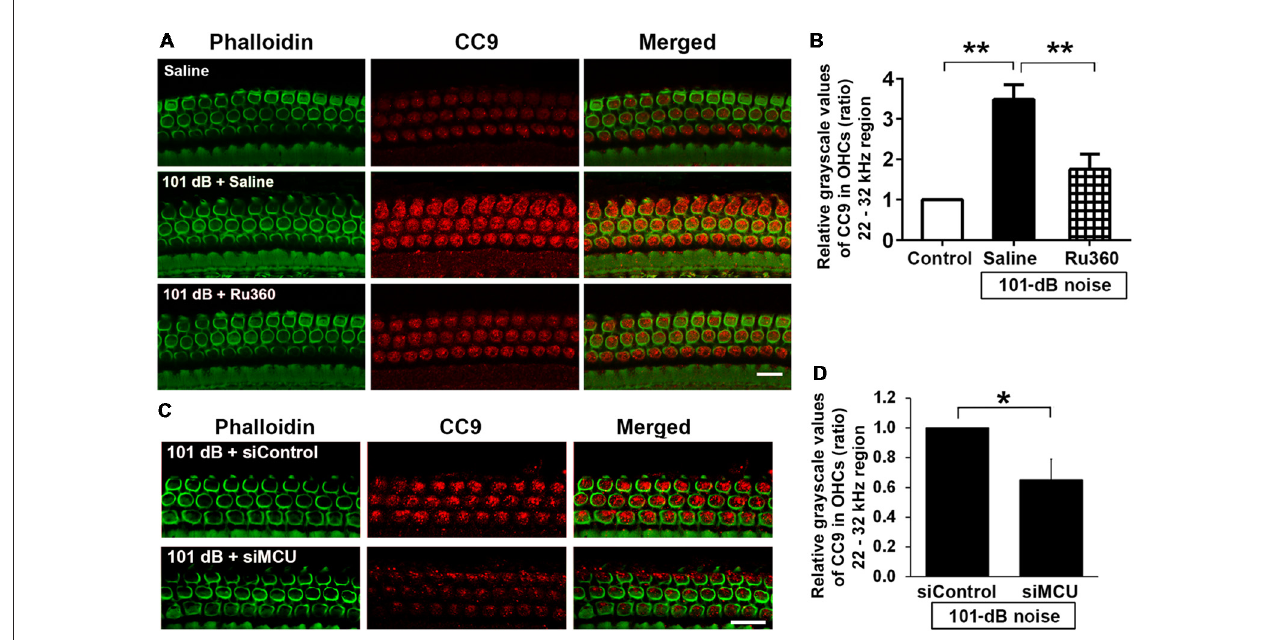
FIGURE 5 | Inhibition of MCU via the pharmacological inhibitor Ru360 or siMCU attenuated noise-induced increases in cleaved caspase 9 (CC9) in OHCs of the basal turn. (A) Representative images show an increase in immunoreactivity for CC9 (red) in OHCs stained with phalloidin 1 h after completion of the exposure (panel 2) compared to control mice without exposure (panel 1). Treatment with Ru360 attenuated noise-induced CC9 in OHCs (panel 3). Images were taken from the region of the surface preparations corresponding to sensitivity to 22–32 kHz using a Leica SP5 confocal microscope; scale bar = 10 µ m. (B) Quantification of CC9 in OHCs confirmed a significant increase after noise exposure and attenuation of this increase with Ru360 treatment; n = 4 per group with one cochlea used per mouse. Data are presented as means + SD, ∗∗ p < 0.01. (C) Representative images show that pretreatment with siMCU decreases immunoreactivity for CC9 (red) in OHCs stained with phalloidin (green) 1 h after completion of the exposure compared to siControl treatment. Images were taken from the region of the surface preparations corresponding to sensitivity to 22–32 kHz using a Zeiss confocal microscope; scale bar = 10 µ m. (D) Pretreatment with siMCU also significantly reduced noise-increased immunolabeling for CC9 in OHCs compared to mice exposed to scrambled siRNA (siControl). Data are presented as means + SD, n = 4 per group with one cochlea used per mouse, ∗ p < 0.05.